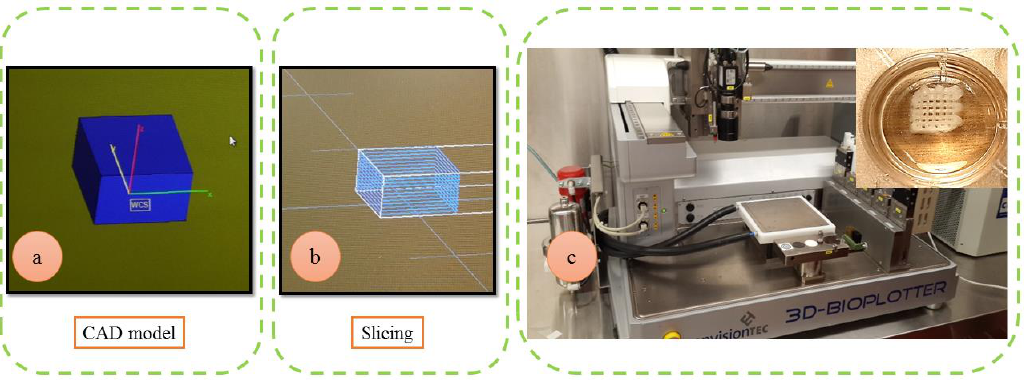
Figure 2. Illustration of printing alginate scaffolds: ( a ) computer-aided-design (CAD) model; ( b ) sliced layers; and ( c ) 3D-Bioplotter used for scaffold printing, with an inserted image showing the alginate scaffold printed in a tissue culture plate. Table 1. Printing condition used in scaffold fabrication.